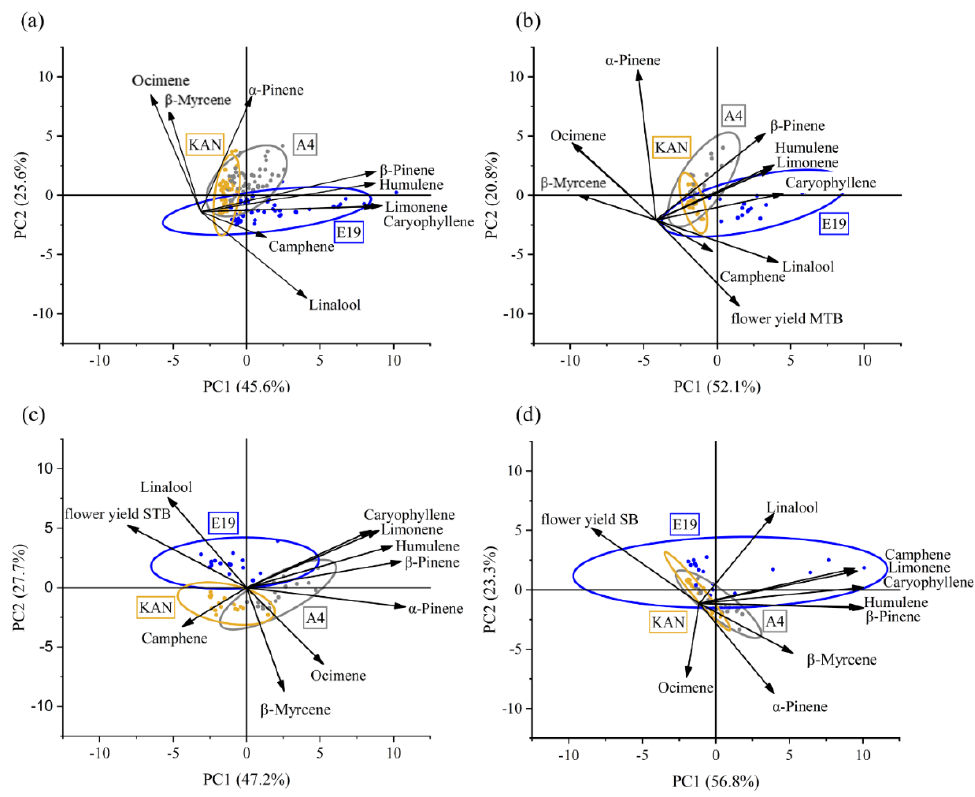
Figure 8. Biplot of the impact of terpene-by-strain period means on ( a ) terpene concentrations for three strains (A4, E19 and KAN), ( b ) terpene concentrations and yield of the main top buds (MTB´s) for three strains, ( c ) terpene concentrations and yield of the side top buds (STB´s) for three strains, and ( d ) terpene concentrations and yield of the side buds (SB´s) for three strains. PC1 and PC2 are principal components 1 and 2.